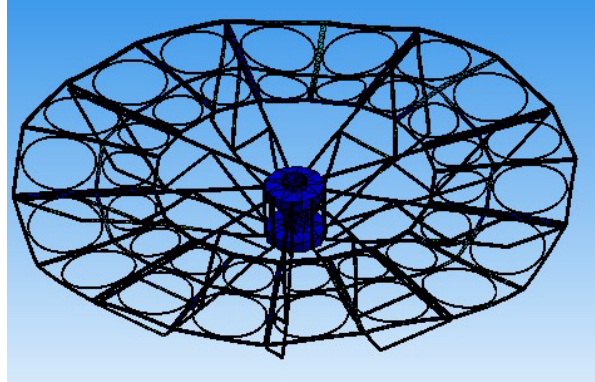
Figure 23. The third-order mode shape of the optimized free vibra- tion.